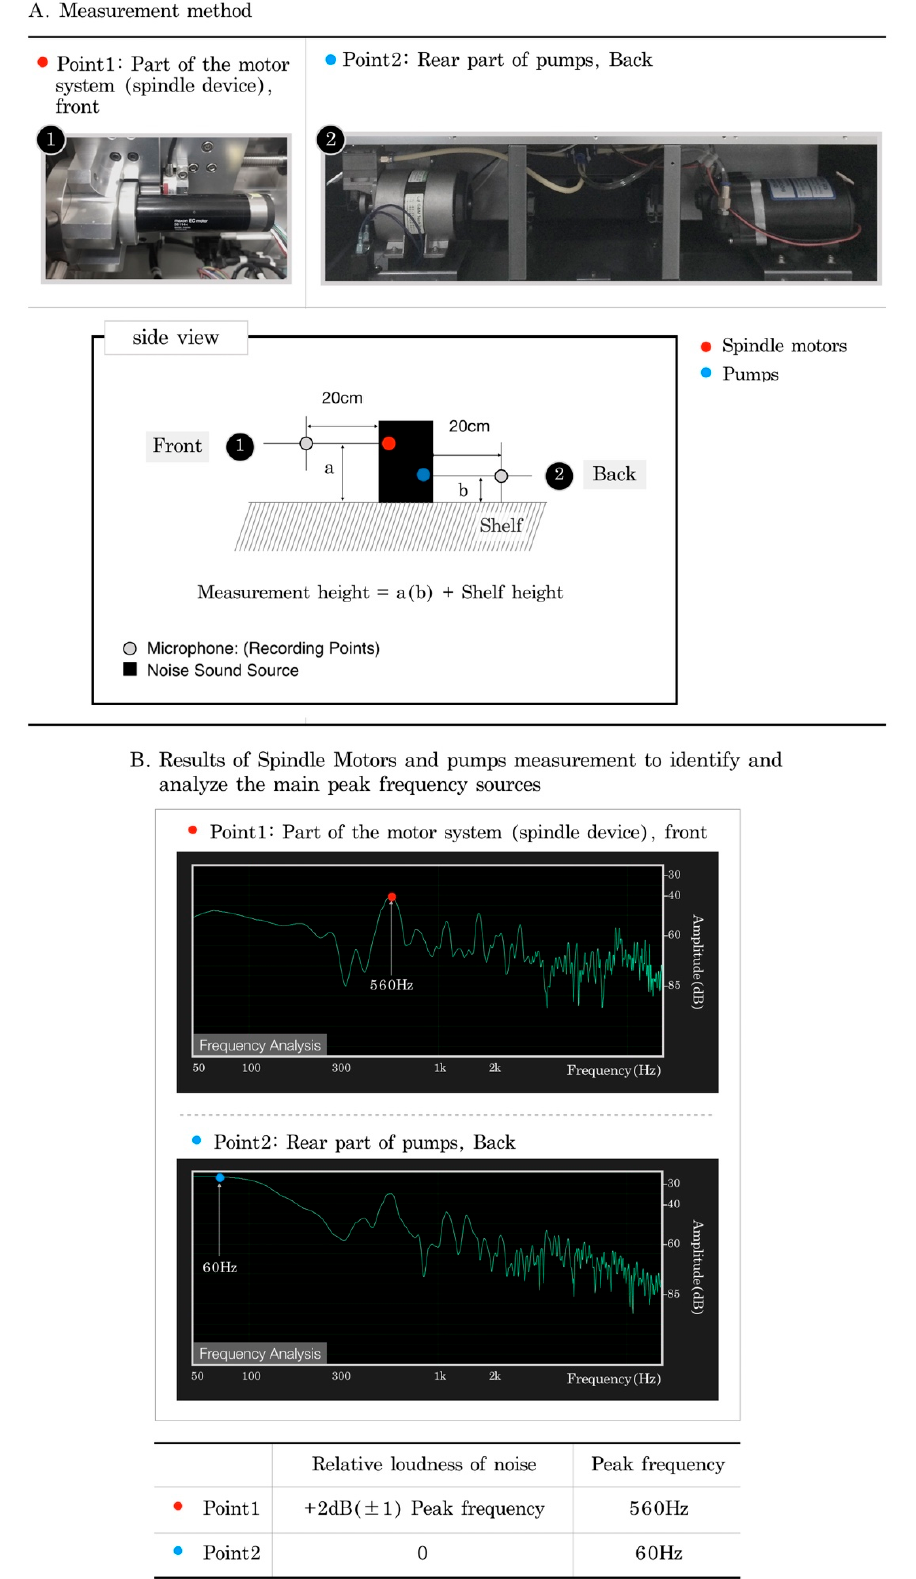
Figure 6. Spindle motor and pump measurements to identify and analyze peak frequency. ( A ) measurement method; ( B ) results of the spindle motor and pump measurement to identify and analyze the main peak frequency.